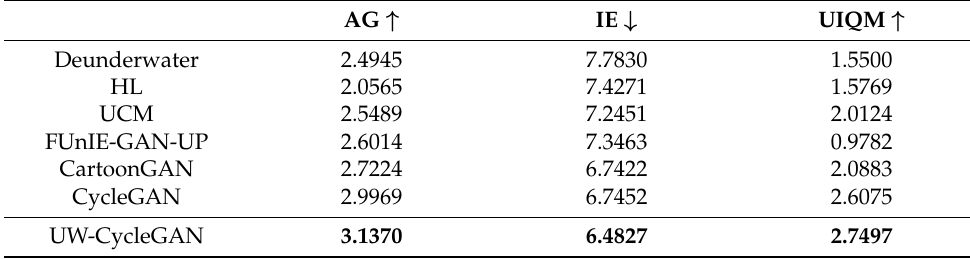
Table 2. Quality evaluation of all methods on the EUVP dataset.